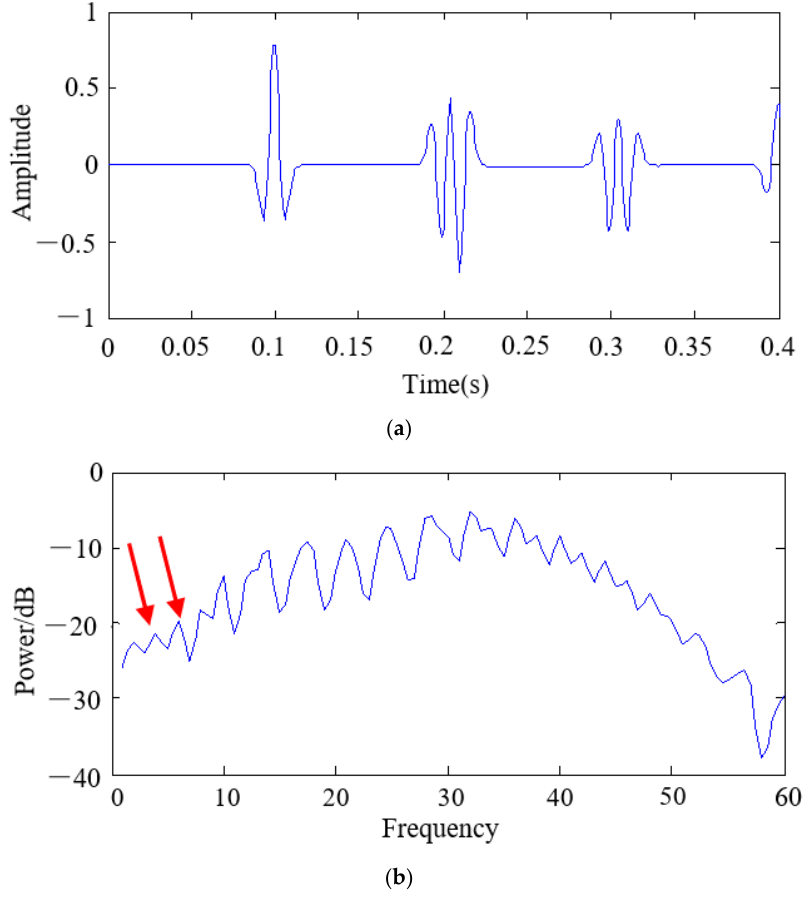
Figure 5. Simulated seismic data after frequency-broadening processing. ( a ) Model data, ( b ) fre- quency spectrum of ( a ).